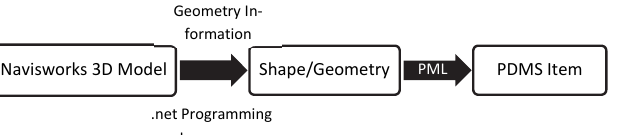
Fig. 4. Equipment / structure / foundations Navisworks® 3D model conversion flowchart